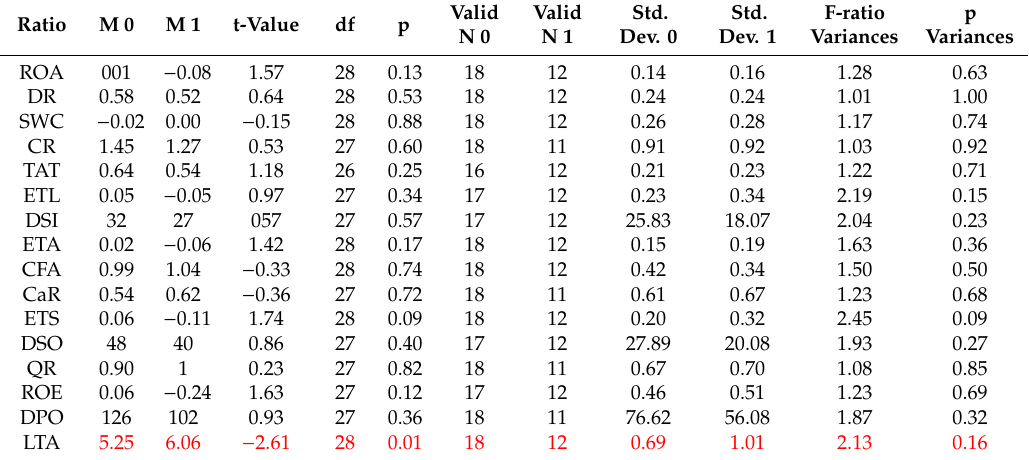
Table A3. The student’s t-test results for the chosen ratios for green (1) and red (0) companies for 2015.